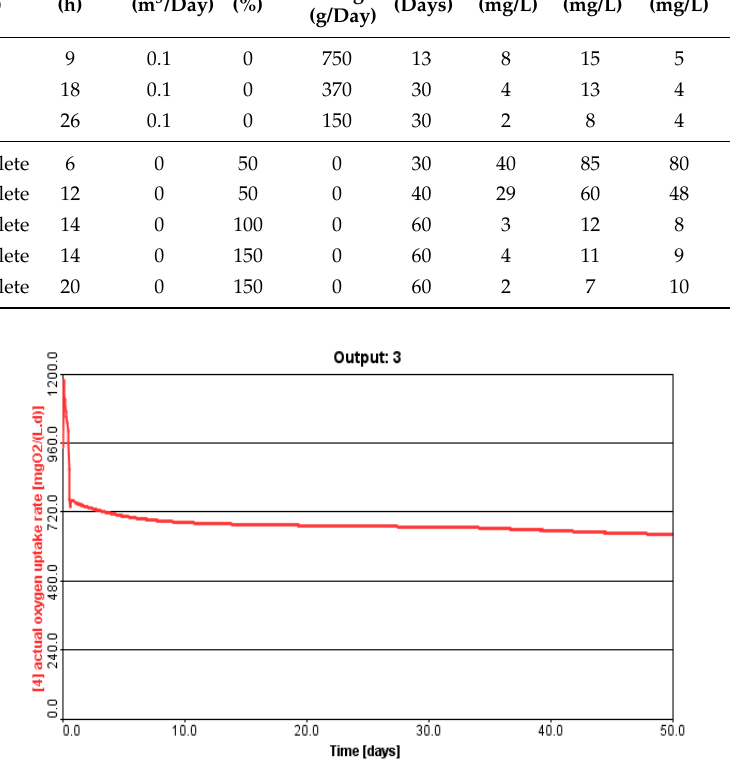
Figure 7. O 2 uptake rate data in the bio treatment unit for scenario 1. Table 3. Sludge production and effluent pollutants concentrations at different operational condi- tions of MBBR and IFAS processes.